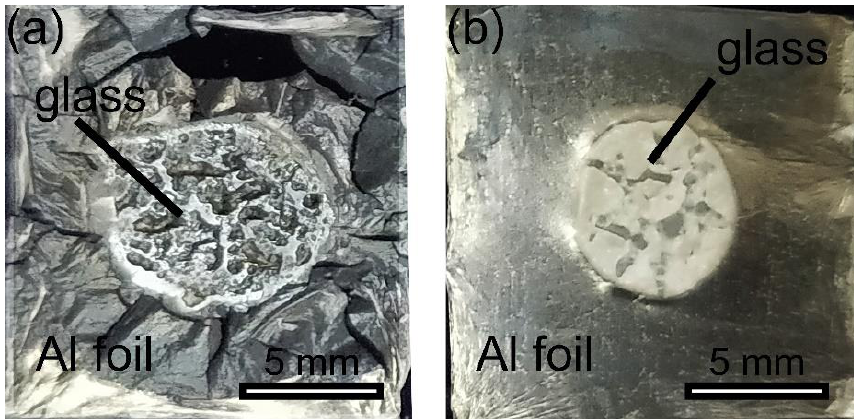
Figure 4. Photographs showing the interaction of glass with Al by firing a glass frit coated in Al foil in an open electric furnace at 700 °C for 1min. (a) G-1 glass frit; (b) G-2 glass frit.